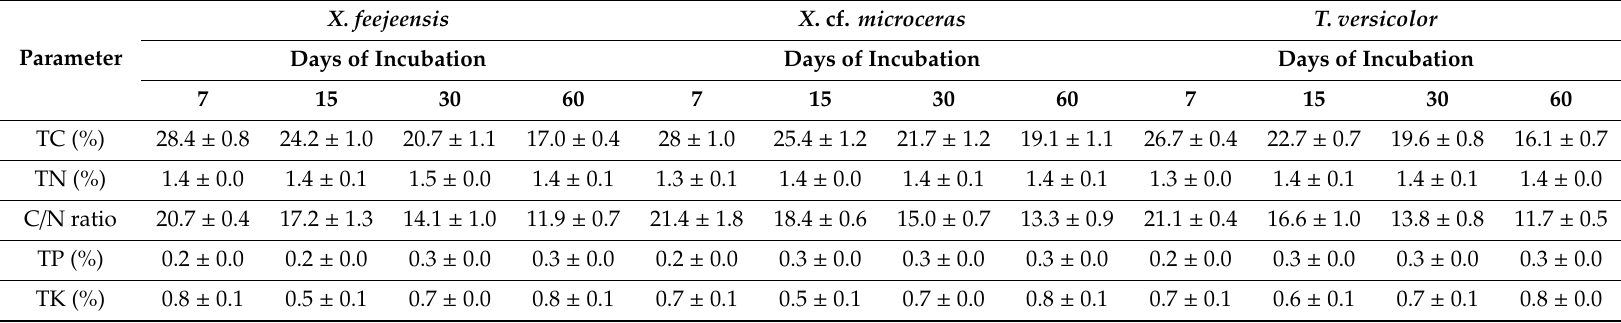
Table 3. Changes in biochemical constituents of Palo Santo waste ( B. graveolens ) during 60 days of solid-state fermentation, with native fungi Xylaria spp. and T. versicolor